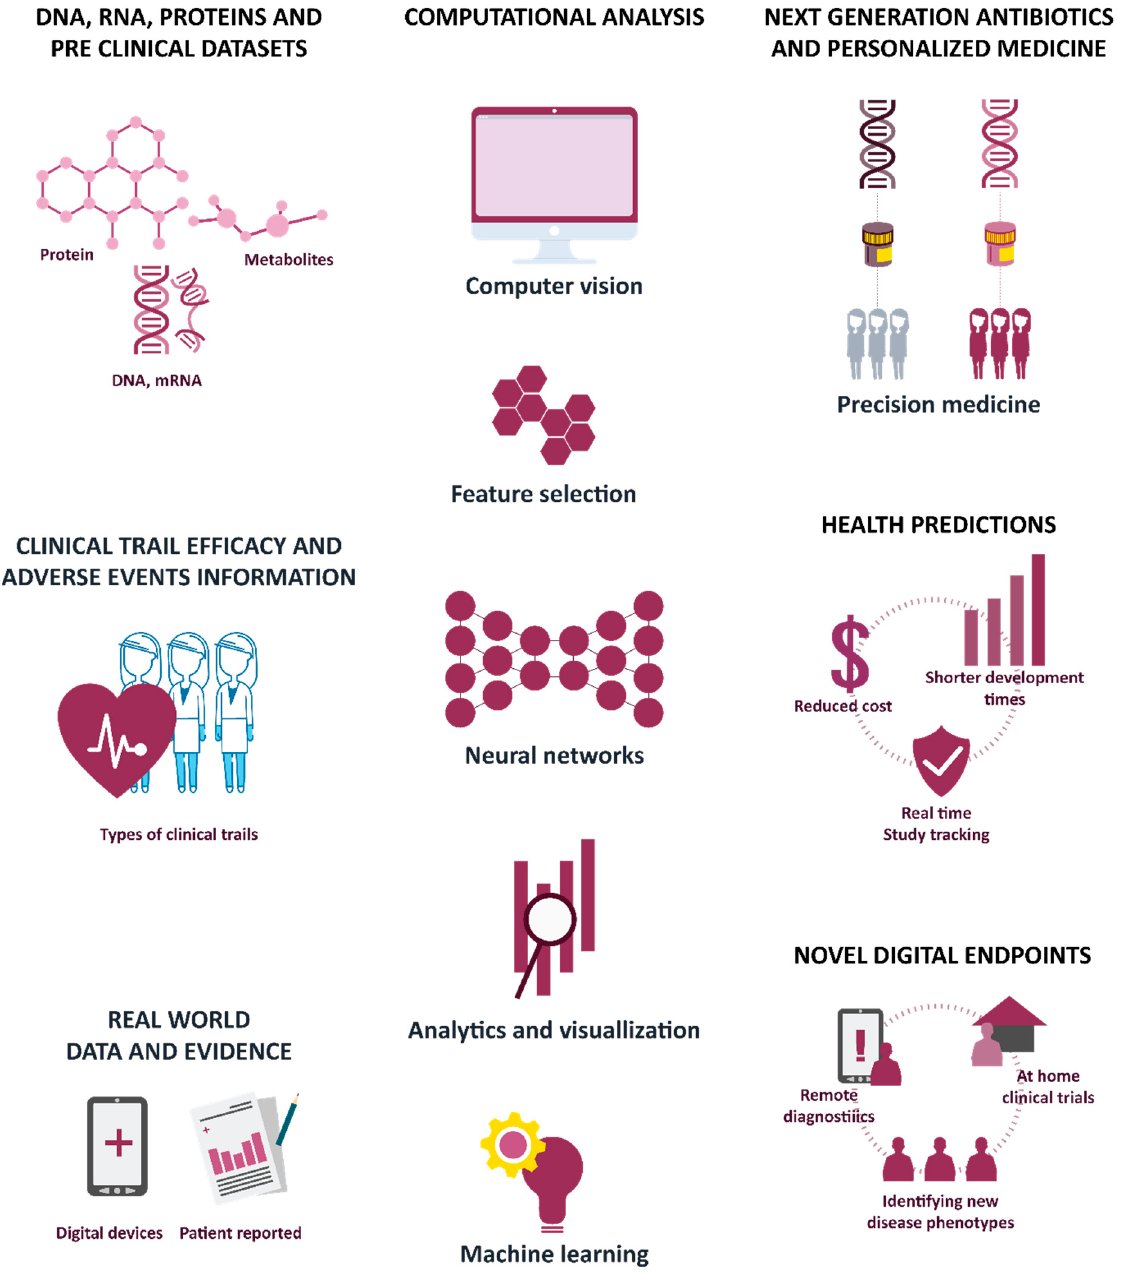
Figure 4. Applications of AI, computer vision, and ML in clinical development; adapted from [56].